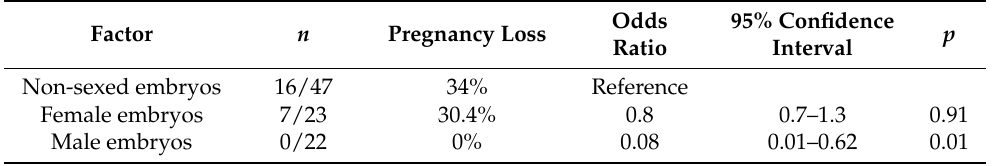
Odds 95% Confidence p Ratio Interval